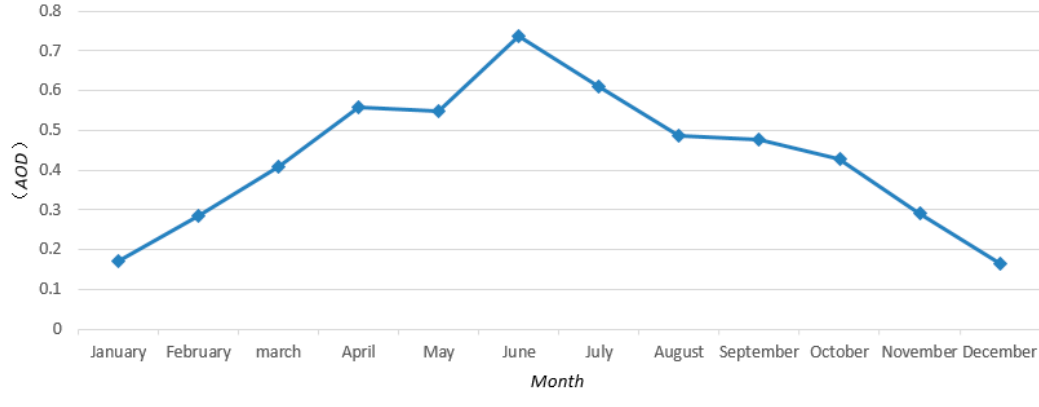
Figure 10. AOD monthly change chart.